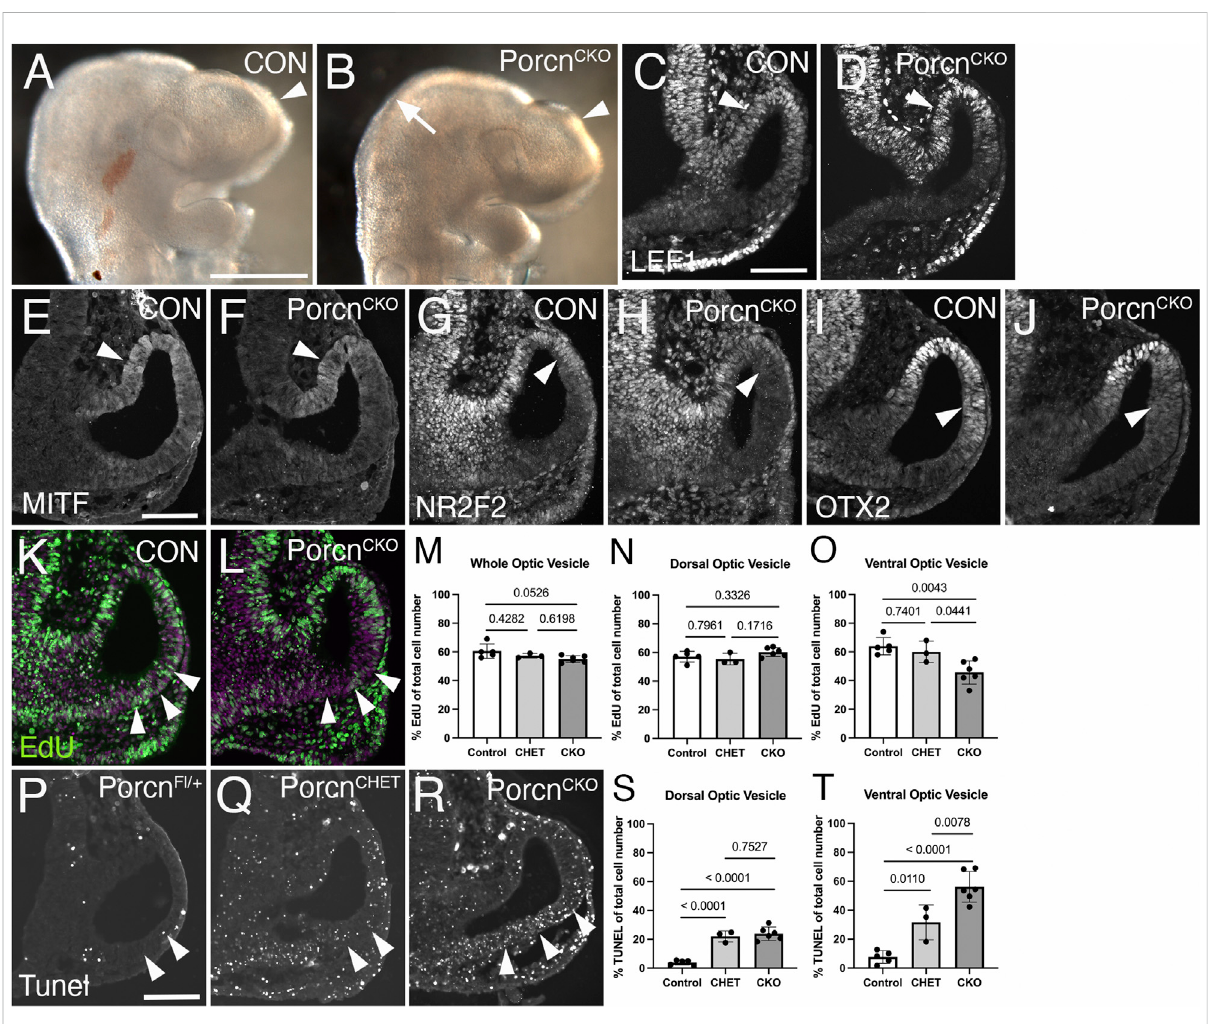
Decrease of proliferation, survival and local NR2F2 and OTX2 expression in the Porcn CKO OV at E9.5. Coronal view of control embryos (A,C,E,G,I,K; Porcn CHET ) and Porcn CKO embryos, induced at E7.4 – 7.5 (B,D,F,H,J,L). (A) Telencephalic vesicle in E9.5 control embryo (arrowhead). (B) Porcn CKO show slightly smaller telencephalic vesicles (arrowhead) and mid-hindbrain regions (arrow). (C) In controls, LEF1 is expressed in the dorsal OV (arrowhead). (D) In Porcn CKO embryos, LEF1 is unaltered (arrowhead). (E and F) MITF expression appears unaffected in the presumptive RPE of Porcn CKO (F; arrowhead). (G and H) In the mutant RPE, NR2F2 can be slightly downregulated in the dorsal OV (H; arrowhead). (I and J) OTX2 can start to be reduced dorsally in the distal OV domain in Porcn CKO (J; arrowhead). (K,L) Edu incorporation (green) in control (K) and in Porcn CKO OV (L) , showing reduced number of EdU-labeled cells in the ventral OV (L; arrowheads). Magenta: Dapi. (M – O) Quanti fi cation of EdU labeled cells in the entire OV (M) , dorsal OV (N) and ventral OV (O) . In Porcn CKO , the number of EdU-labeled cells is signi fi cantly reduced in the ventral OV (O) . (P – R) Coronal view of representative images of Tunel-labeled E9.5 sections induced with tamoxifen at E7.4. Arrowheads mark the Tunel-labeled region in the ventral OV. Compared to Cre -negative controls (P) , overall Tunel signal is increased throughout the tissues in Porcn CHET and Porcn CKO embryos (Q) . In the ventral OV of Porcn CKO embryos, more Tunel-labeled cells are detectable (R) , compared to Porcn CHET (Q) . (S,T) Quanti fi cation of Tunel- labeledcells intheventral OVshows asigni fi cantincreasein Porcn CKO (T) .Quantitativedata aremeans±s.d. One-way ANOVAwithTukey ’ sposthoc analysiswasappliedforstatisticalanalysis,and p -valuesareindicatedonthehorizontallinesineachgraph(signi fi cance < 0.05).ScalebarsA:0.5 mm; C, E, P: 0.1